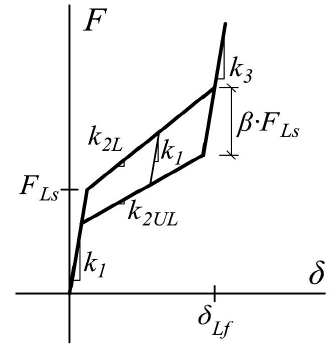
Figure 14. Conventional flag-shape model.